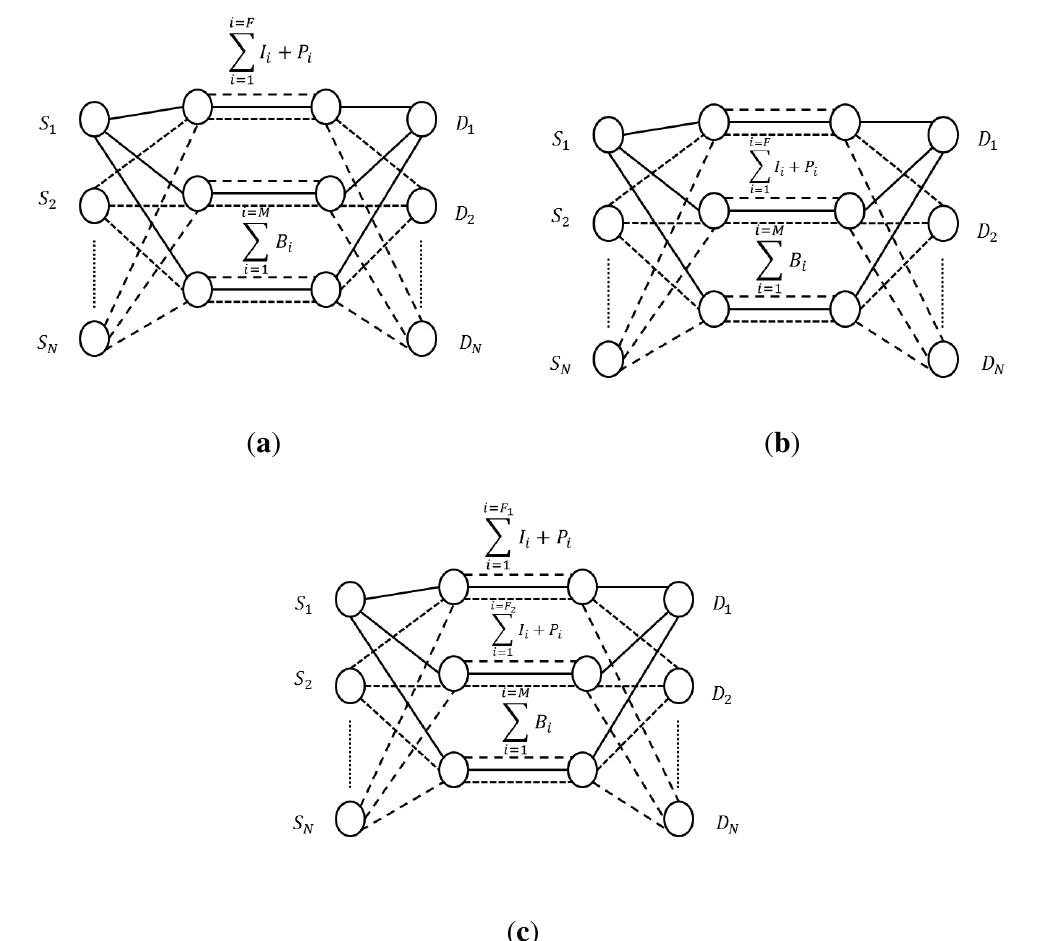
Figure 5. Three possible allocation situations after playing the game. F and M represent the number of (I+P) and B frames to be sent, respectively. All the B frames are always sent through the worst path. ( a ) All the I+P frames are sent through the best path; ( b ) All the I+P frames are sent through the medium-quality path; ( c ) I+P frames will be sent through the best path with a certain probability p and through the second best path with a probability 1- p . F and F represent the number of (I+P) frames sent through the best path and the 1 2 + F medium-quality path, respectively, being F = F 1 2